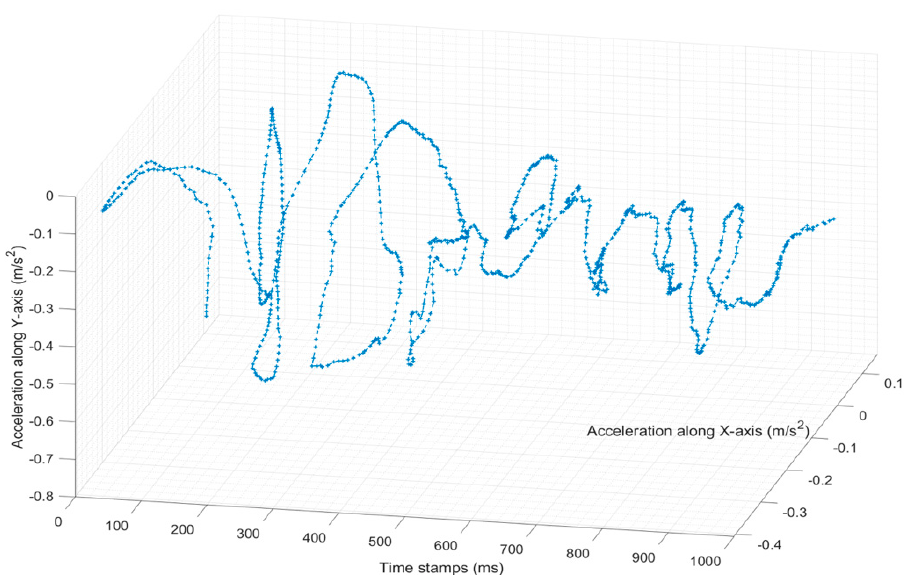
Figure 10. Vertical motion path inside the ship’s hull along the vertical cell guides.